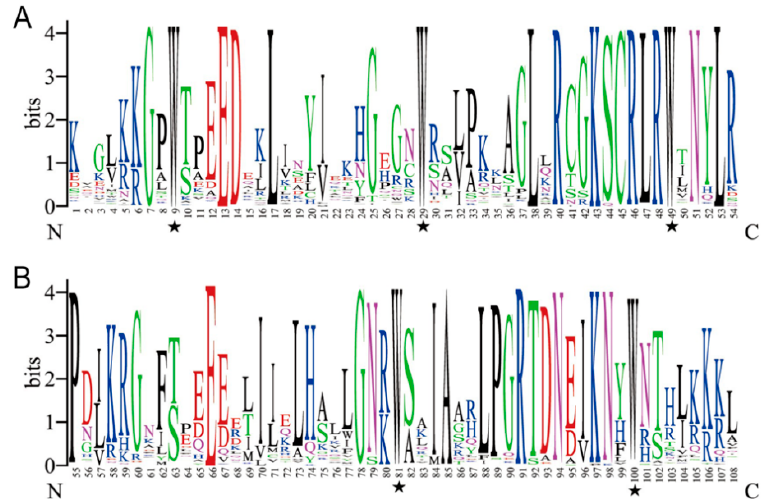
Figure 2. Consensus sequence and the level of conservation of R2R3-MYB domains in Petunia . The sequence logos of the R2 ( A ) and R3 ( B ) repeats are based on full-length alignments of petunia R2R3-MYB domains. The bit score indicates the information content for each position in the sequence. Asterisks indicate the conserved residues Trp (W) in the MYB domain.